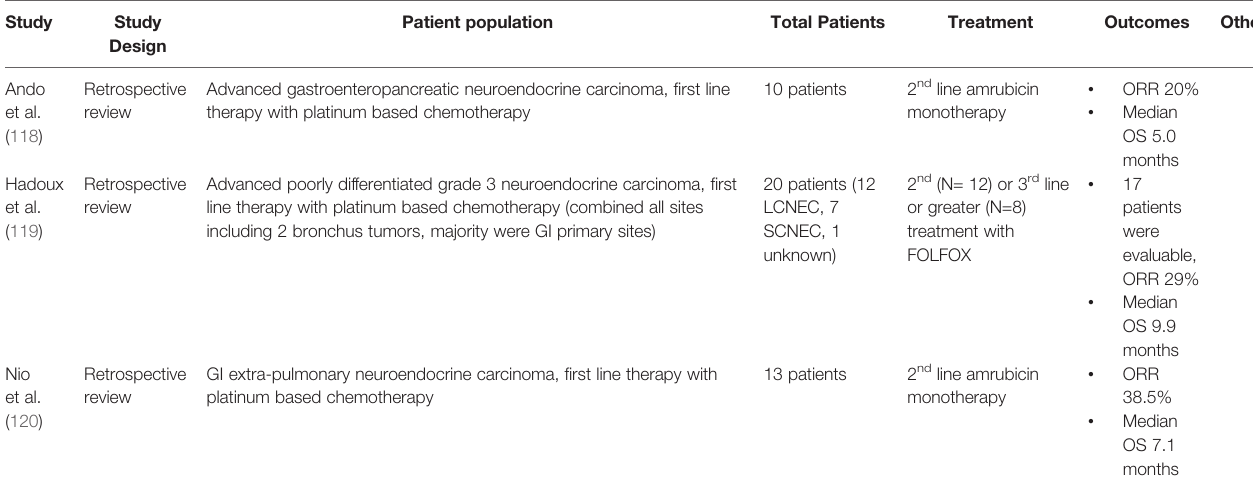
TABLE 10 | Key Papers Describing 2 nd /3 rd Line treatments in Metastatic Extra-Pulmonary LCNEC (most studies report outcomes for cohorts with combined SCNEC and LCNEC).